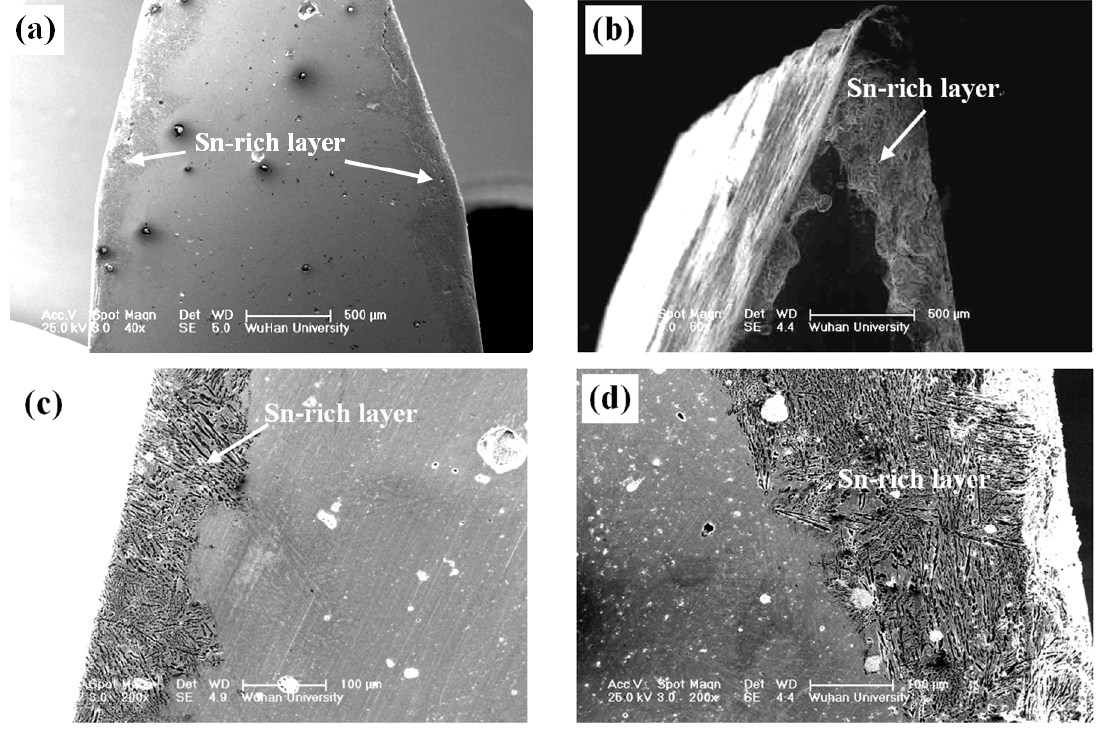
Figure 3. Cross-section SEM morphologies of the sword: ( a , b ) low magnification; ( c , d ) high magnification.